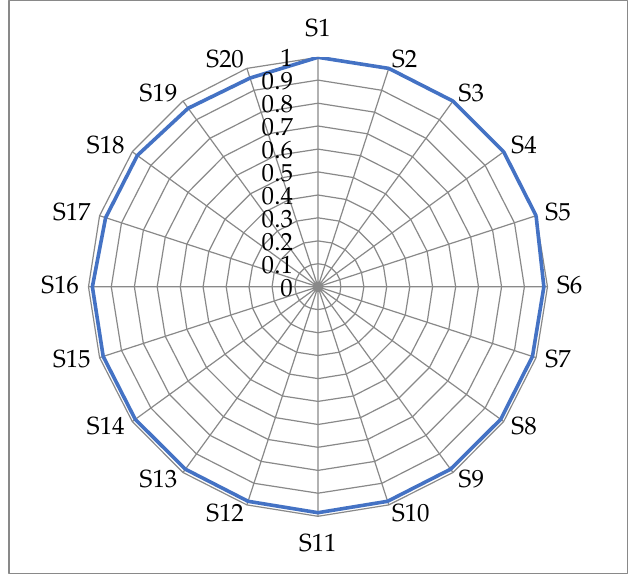
Figure 5. The values of the Spearman’s coefficient of the rank correlations for 20 scenarios with the changes in weight coefficients of the criteria in relation to the initial rank of alternatives.